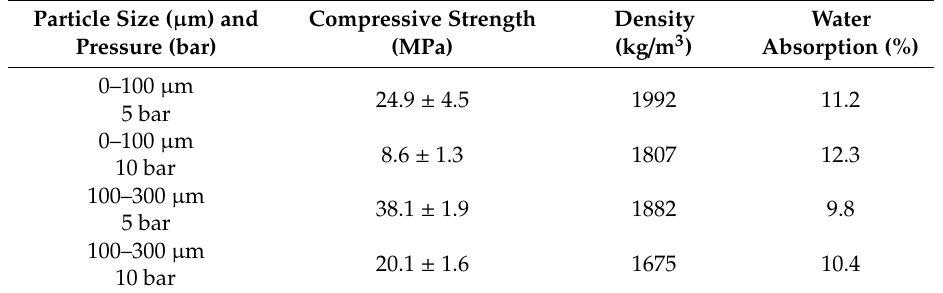
Table 9. Compressive strength, water absorption and density results for carbonated APP EPA compacts.